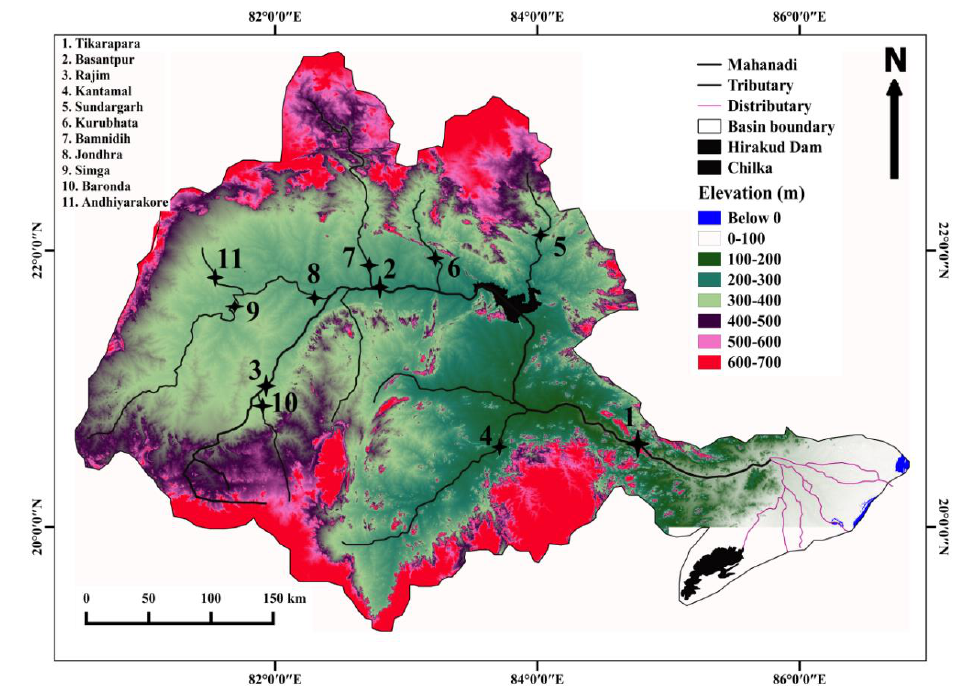
Figure 1. The elevation map of the Mahanadi River basin with the geographical location of 11 gauging stations [48].